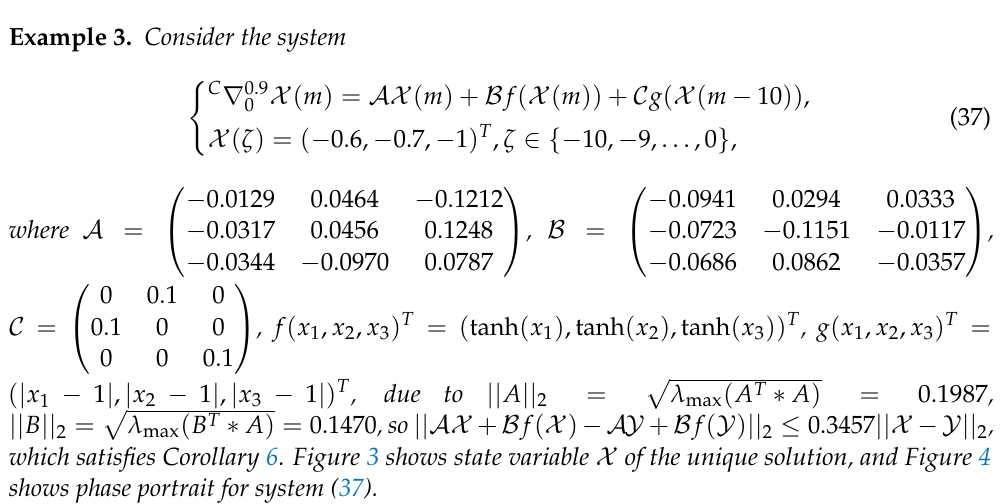
Figure 2. X ( m ) of system (34) for m ∈ [ − 3,60 ]